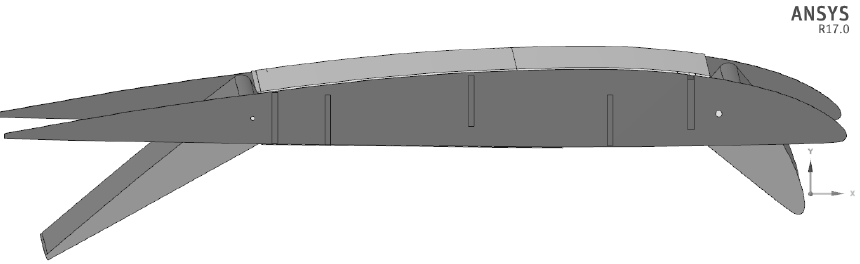
Figure 20. CFD model of the adaptive wing prototype.